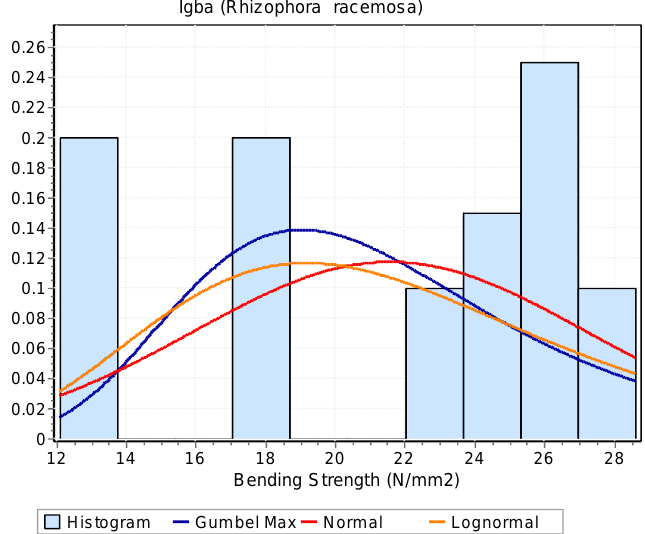
Fig. 7. Probability Density Function Plots for bending strength of Rhizopora racemosa.